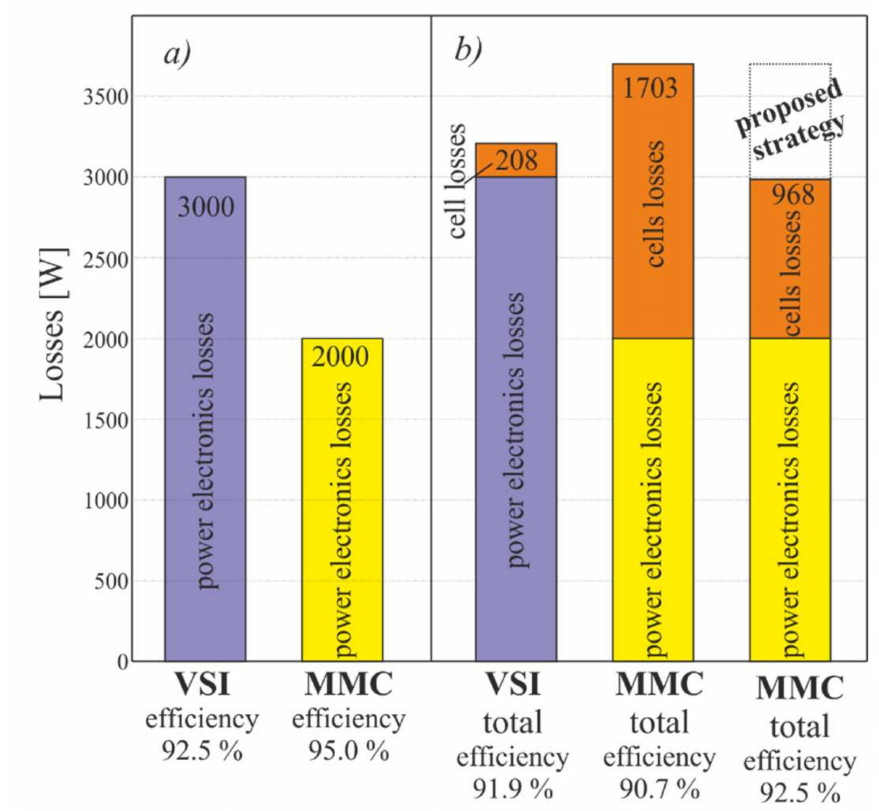
Figure 7. ( a ) Power losses of an 80 kW–24 kWh converter realized by the MMC and VSI solution: ( a ) Power electronics losses and ( b ) all